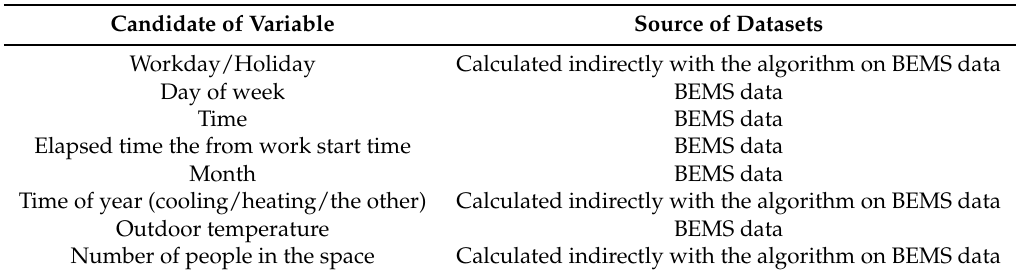
Table 3. Candidate for variables for forecasting demand in buildings.